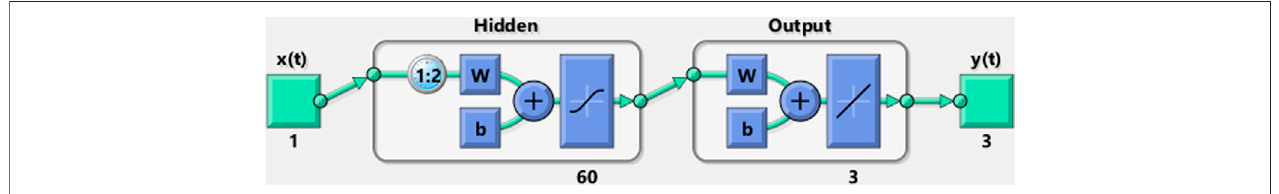
FIGURE 5 | Internal structure of NAR.